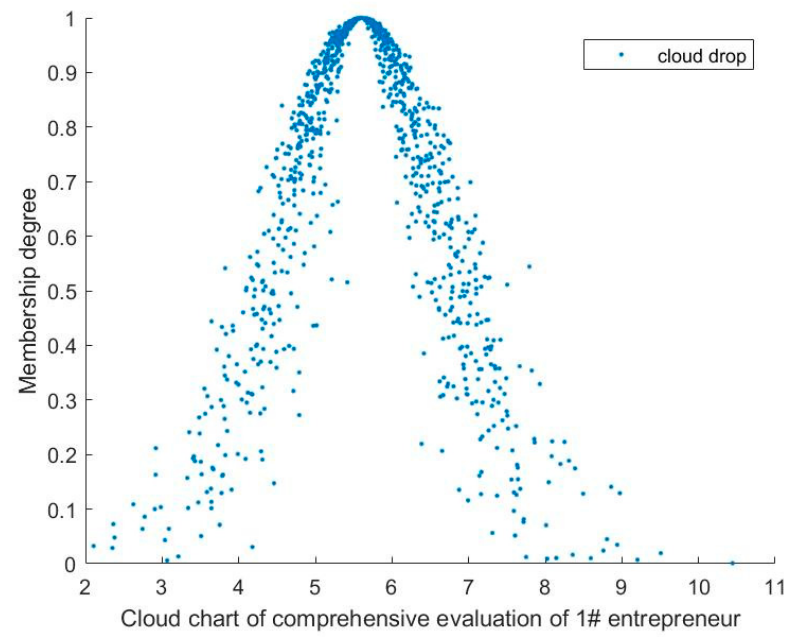
Figure 2. The CM of the comprehensive evaluation of 1# entrepreneur.